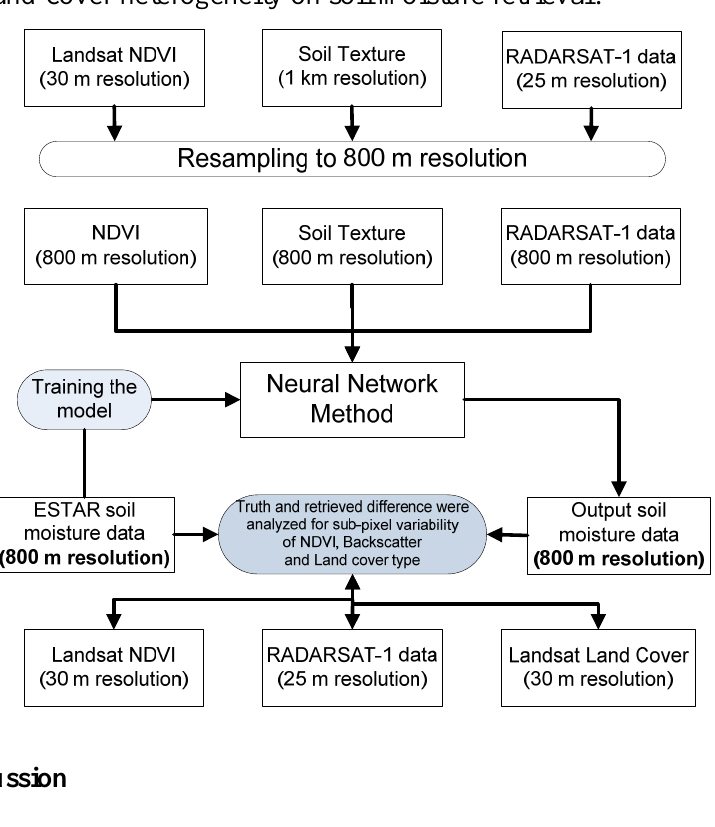
Figure 2. Schematic of flow chart data resolutions to analyze impact of sub-pixel variability and land-cover heterogeneity on soil moisture